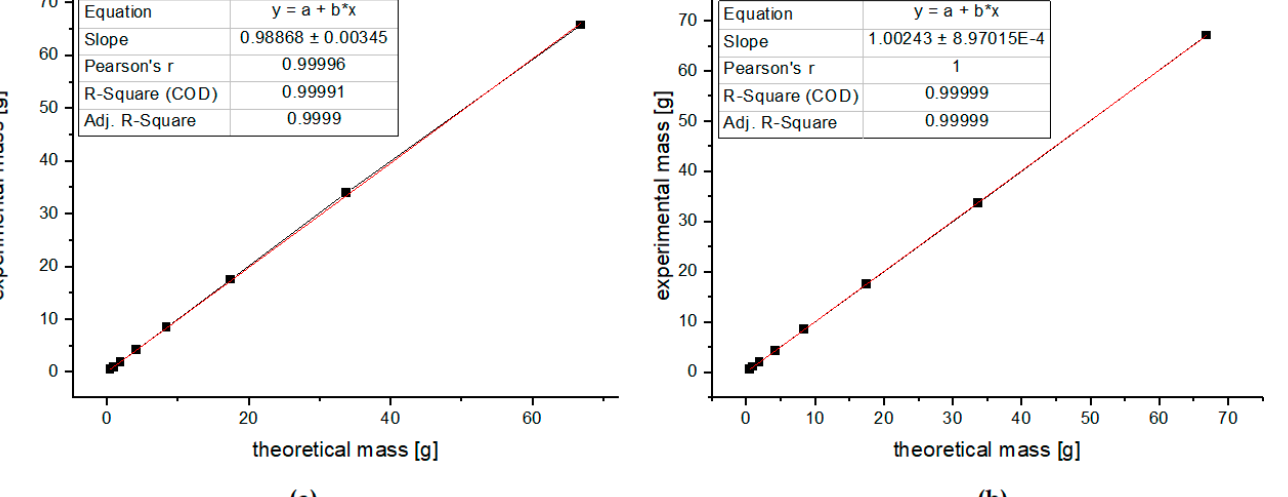
Table 4. The intra-day and inter-day repeatability (average value, SD; coefficient of variation, CV) of the applied method for the determination of Glc concentration in standard sample. Experiment Number